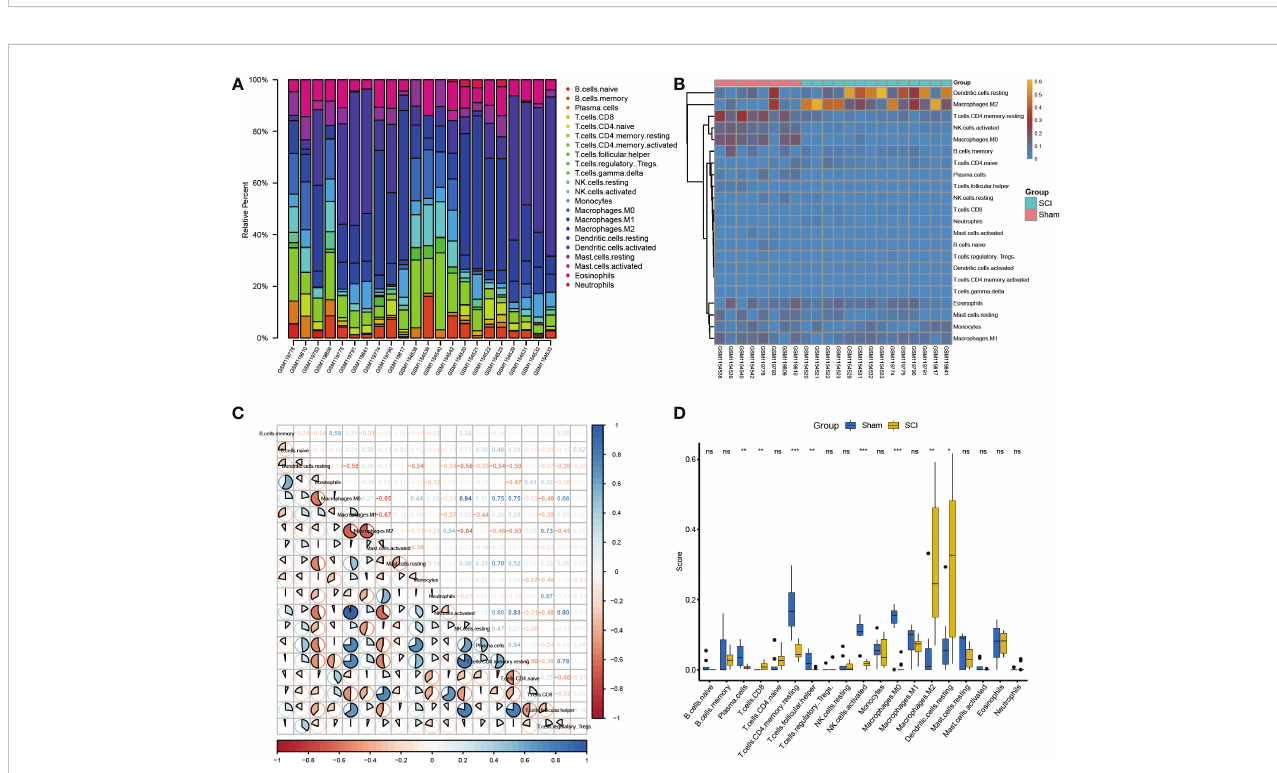
FIGURE 5 Immune in fi ltration analysis of bulk RNA-seq datasets. (A) Immune in fi ltration of the 22 immune cells in GSE5296 and GSE47681dataset. (B) Immune in fi ltration heatmap in GSE5296 and GSE47681dataset. (C) Correlation heatmap of immune cells. (D) The expression difference of 22 immune cells between SCI and uninjured samples. *P < 0.05, **P < 0.01, ***P <